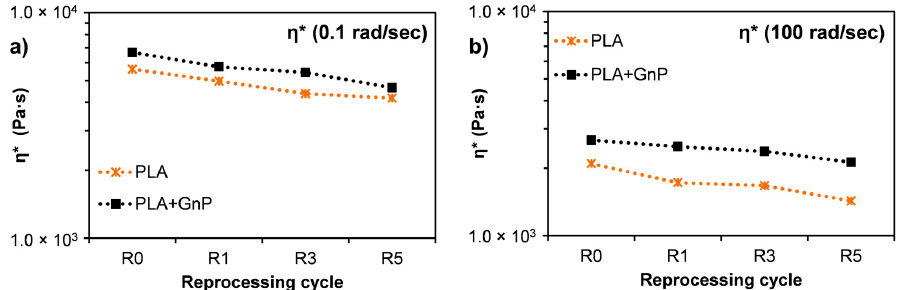
Figure 8. Complex viscosity as a function of reprocessing cycles for PLA and PLA + GnP systems at ( a ) 0.1 rad/s and ( b ) 100 rad/s.